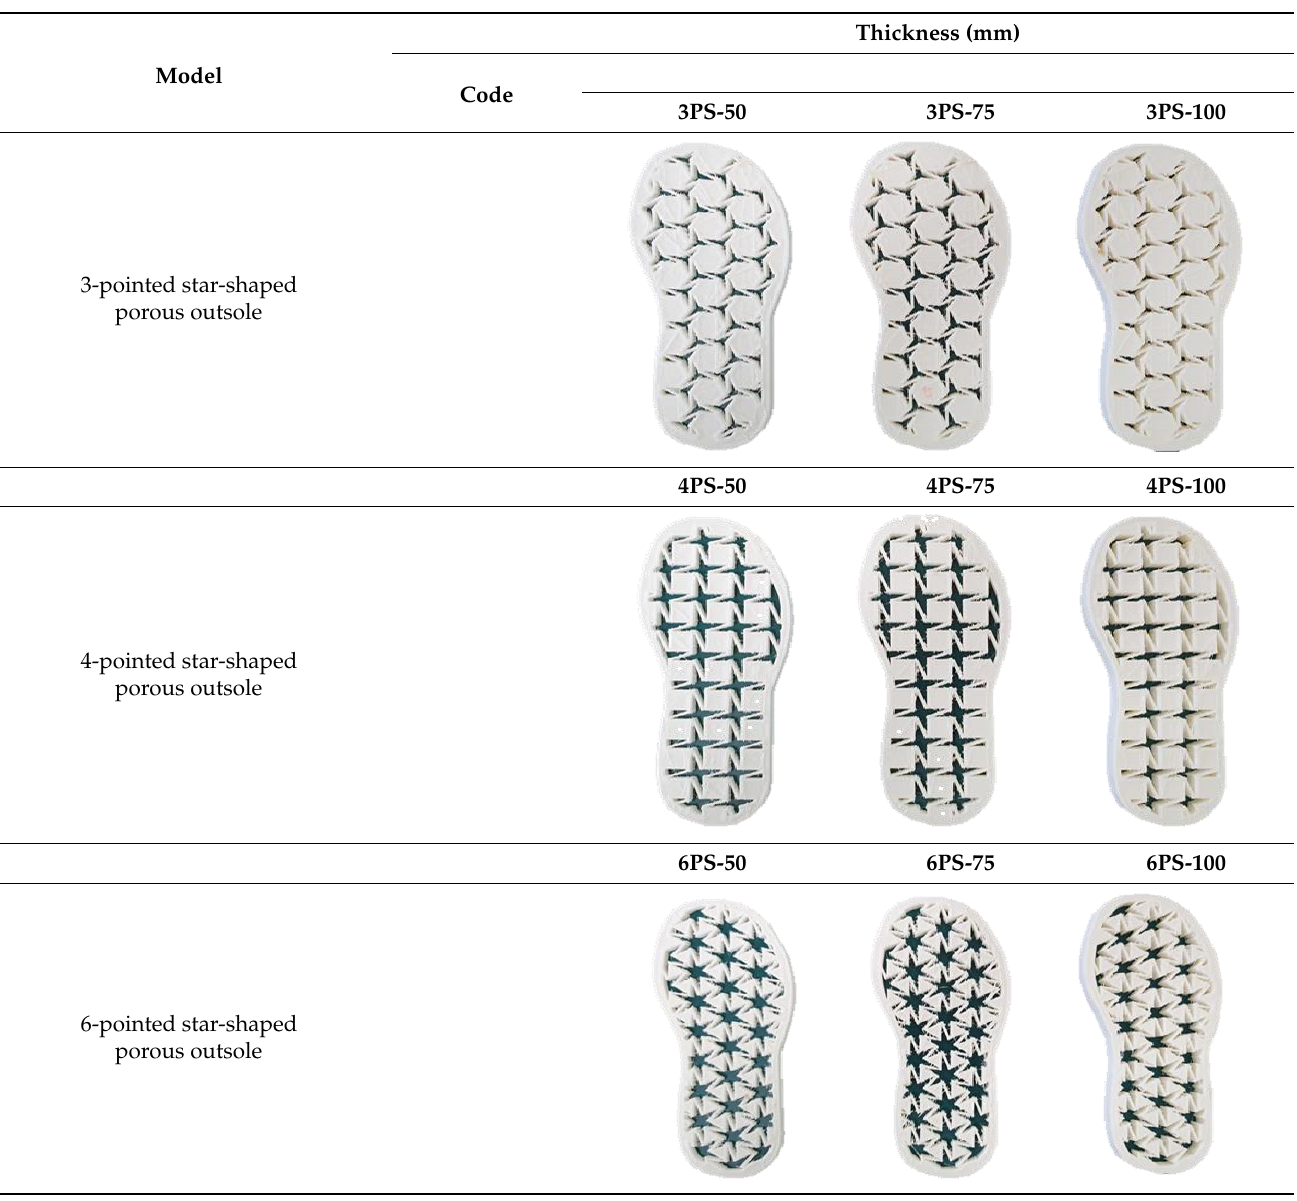
Table 1. Morphology image of the LW 3DP 3-, 4-, and 6-PS outsole piece extruded in various thicknesses. Table 1 Morphology image of the LW 3DP 3-, 4-, and 6-PS outsole piece extruded in various Table 1 Morphology image of the LW 3DP 3-, 4-, and 6-PS outsole piece extruded in various thicknesses. thicknesses. Table 1 Morphology image of the LW 3DP 3-, 4-, and 6-PS outsole piece extruded in various